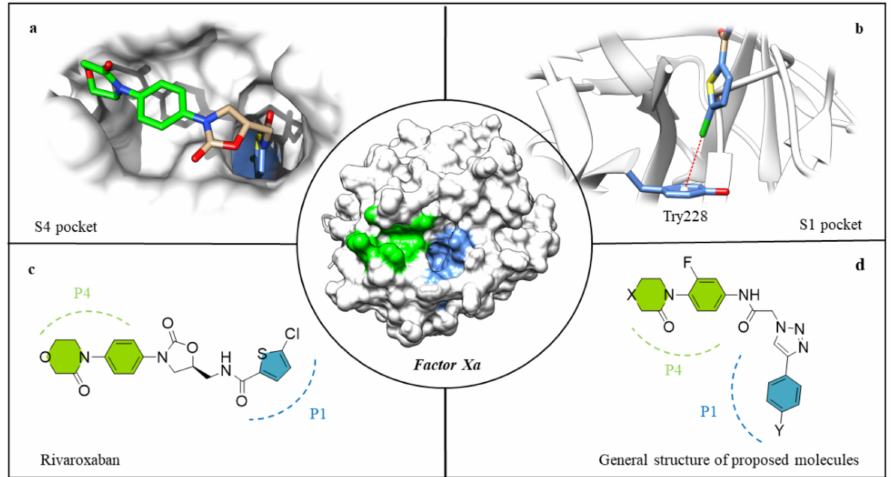
Figure 1. Rivaroxaban interaction in the S4 pocket ( a ), rivaroxaban interaction in the S1 pocket ( b ), chemical structure of rivaroxaban ( c ), general chemical structure of the molecules synthesized in this work ( d ). In the FXa, the blue fragment represents S1 and the fragment in green S4,